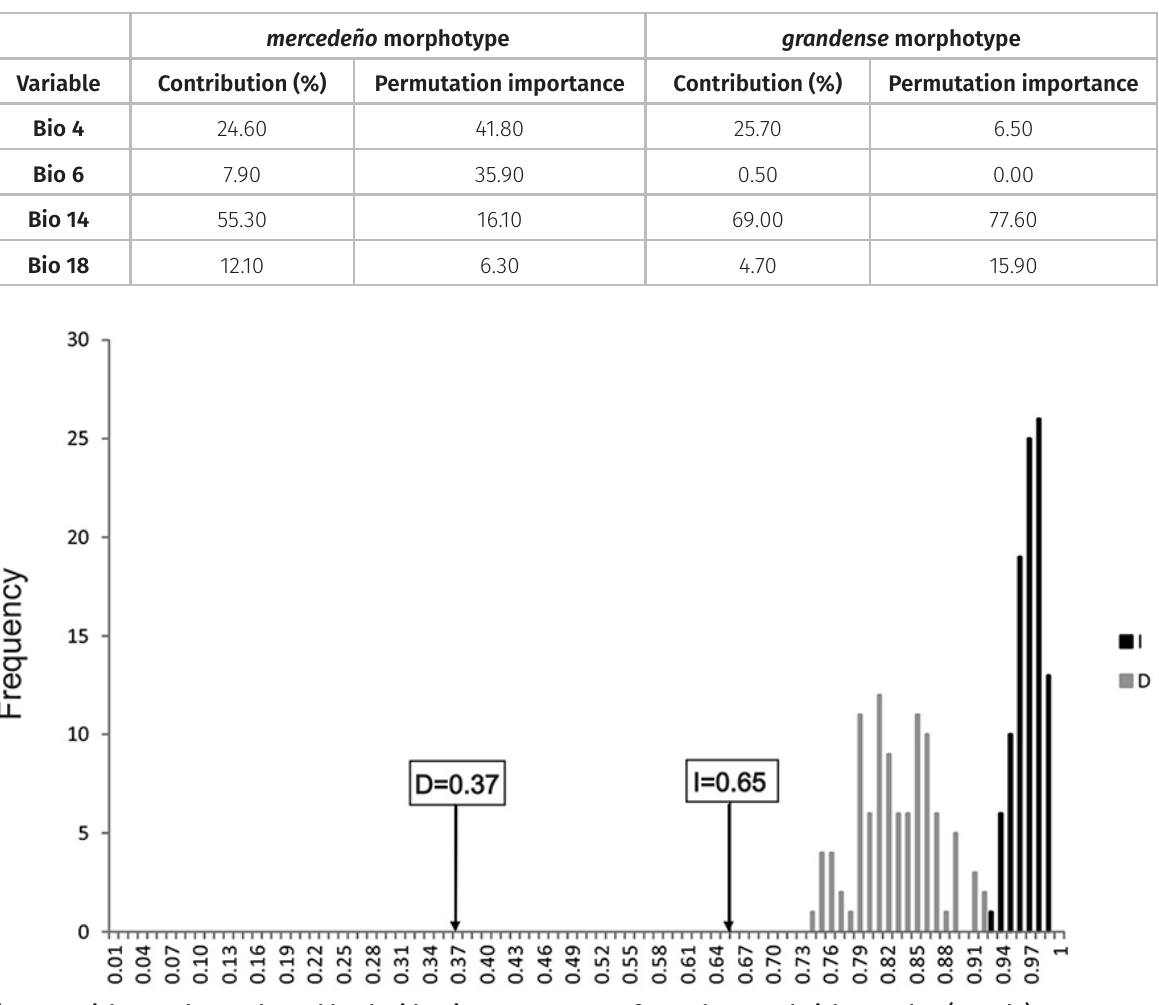
Table II. Contribution and permutation values for the four variables used in current ENMs for the morphotypes of Turnera sidoides subsp. carnea . Bio 4= Temperature Seasonality (standard deviation × 100), Bio 6= Minimum